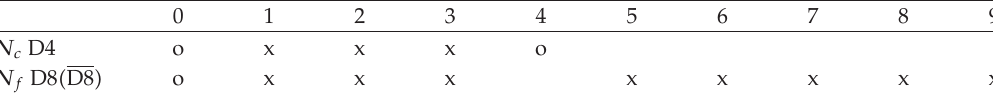
Table 2: Brane configuration of the Sakai-Sugimoto